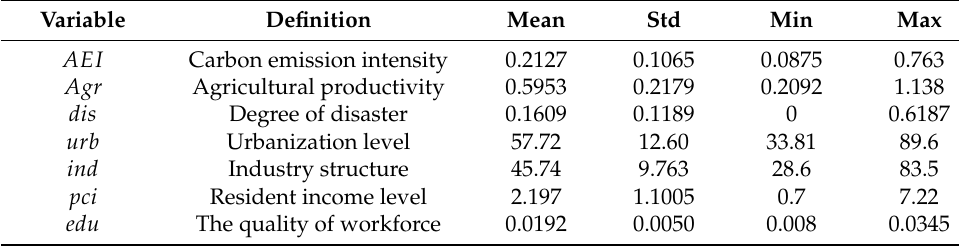
Table 4. Descriptive statistical analysis.